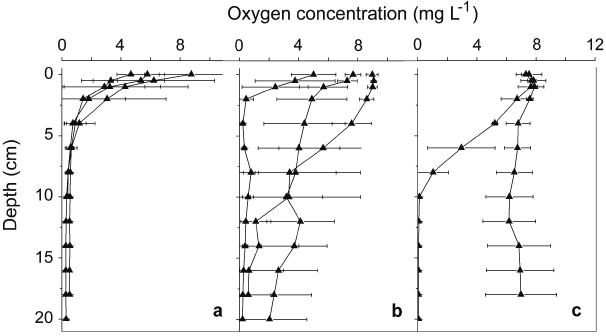
Fig. 2. Oxygen depth profiles in submerged stream sediments at sites were pore water was (a) upwelling ground water, (b) a mix- ture of stream and ground water, and (c) downwelling stream wa- ter (upstream of the alluvial fan) in the three main stream channels of the Chicken Creek Catchment. Symbols and error bars indicate means ± 1SD of three measurements made within areas of 10cm 2